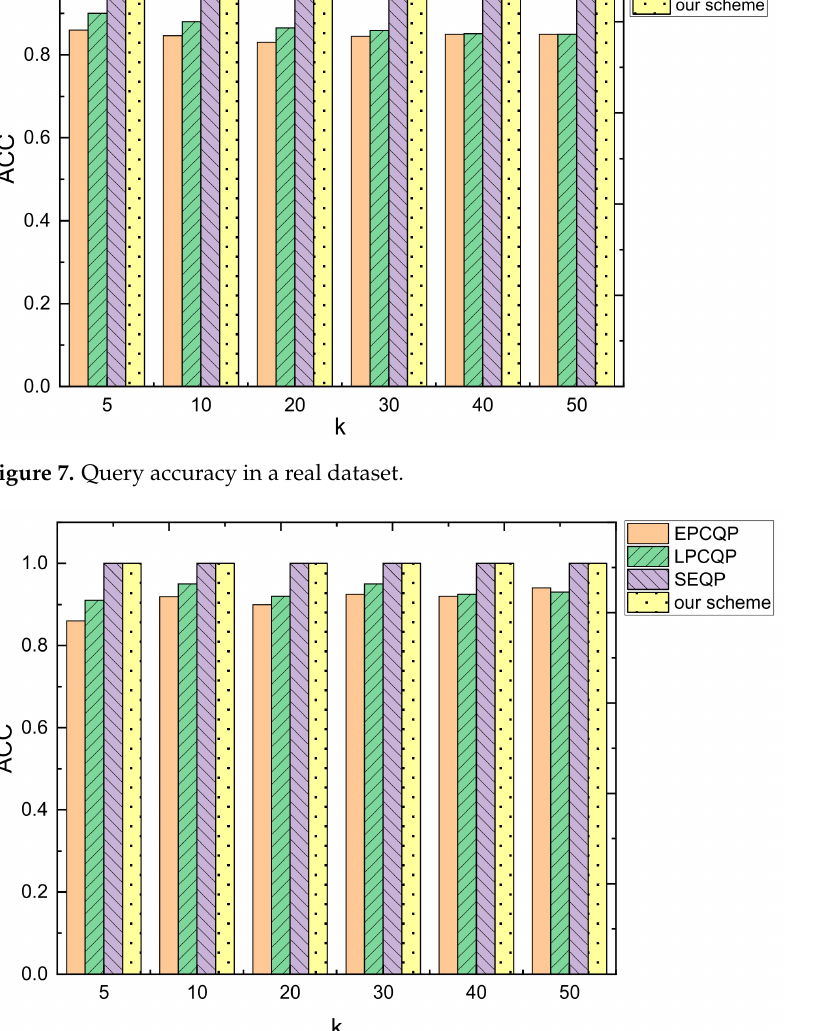
Figure 8. Query accuracy under uniform